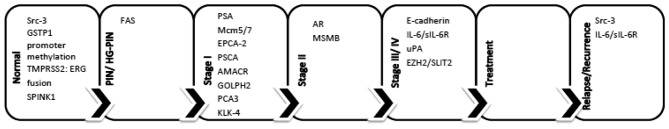
Emerging biomarkers of prostate cancer: continuum of disease progression and stage at which respective biomarkers are anticipated to facilitate clinical utility.